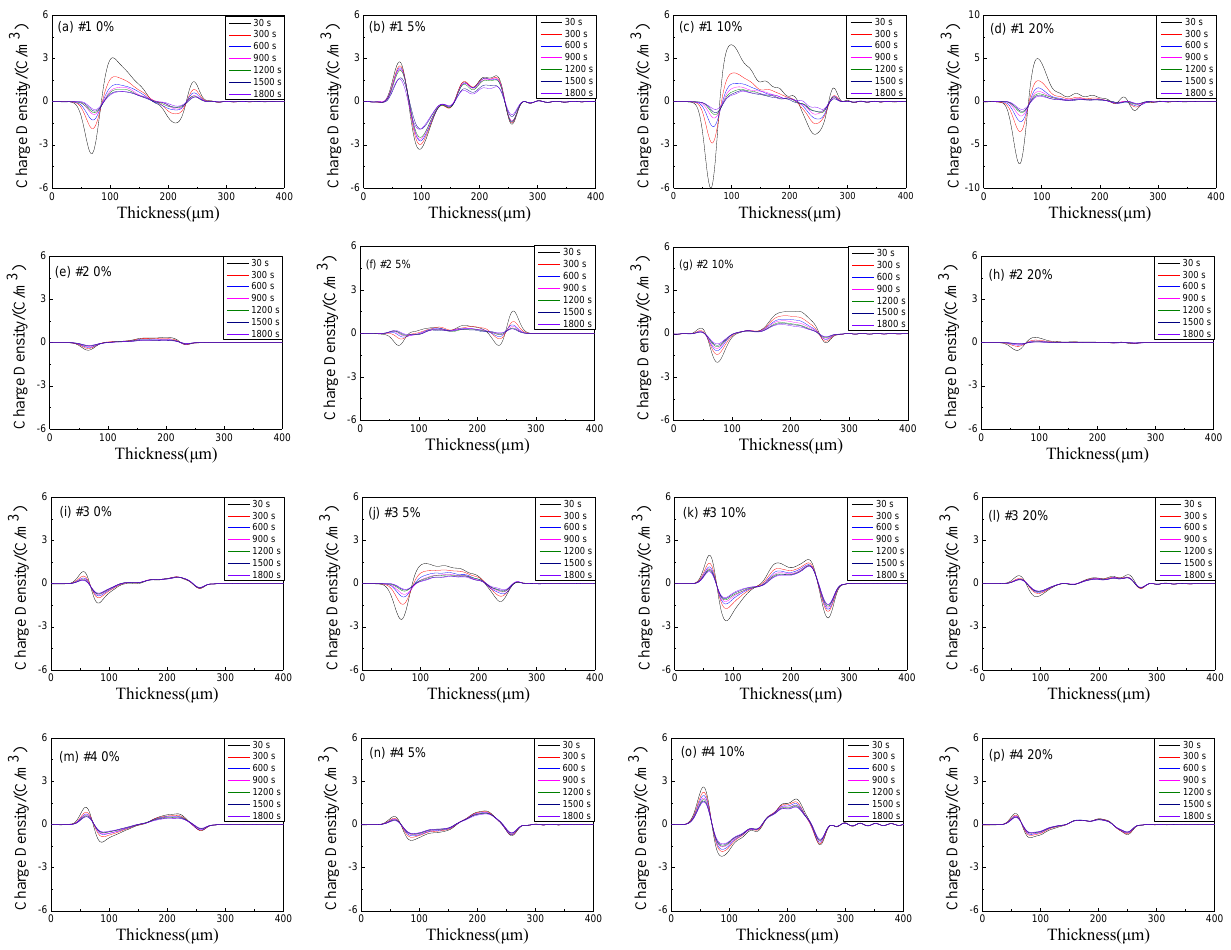
Figure 11. Depolarization space charge distribution curves of each sample.(( a – d ) are the space charge distribution curves of sample 1 under 0%, 5%, 10% and 20% tensile ratio in short circuit; ( e – h ) are the space charge distribution curves of sample 2 under 0%, 5%, 10% and 20% tensile ratio in short circuit; ( i – l ) are the space charge distribution curves of sample 3 under 0%, 5%, 10% and 20% tensile ratio in short circuit; ( m – p ) are the space charge distribution curves of sample 4 under 0%, 5%, 10% and 20% tensile ratio in short circuit).